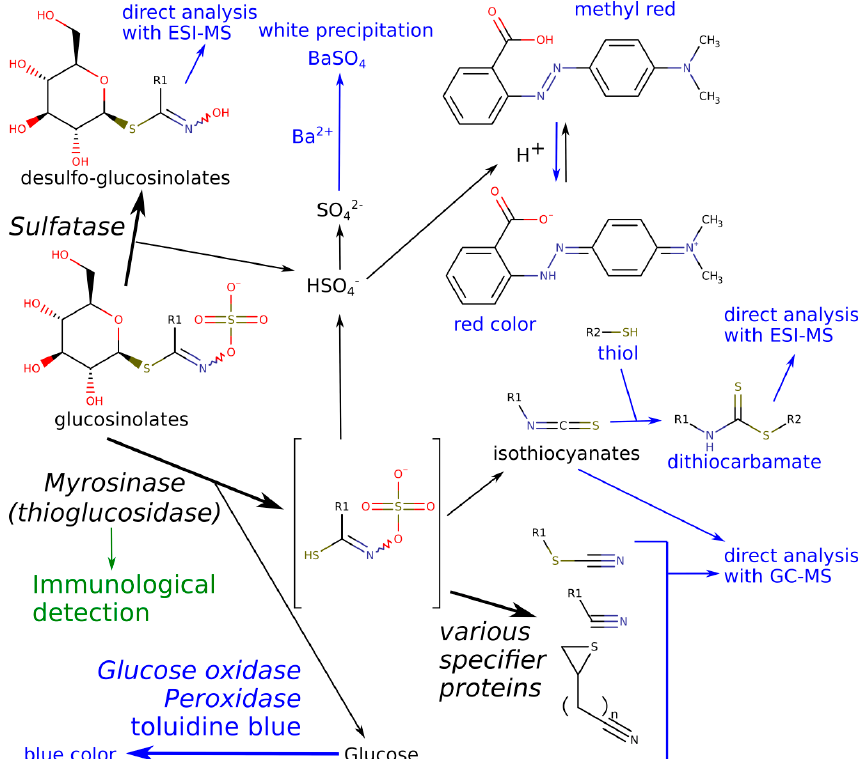
Figure 1. The main breakdown scheme of glucosinolates with possible detection methods of the products. Enzymatic reactions are shown with bold arrows, enzymes have italic font. The reactions that occur in vivo, are shown in black. Detection methods are either blue (those which require an operating myrosinase) or green (methods reliant only on similarity of sequences). The default rearrangement products of the thiohydroximates are isothiocyanates, alternative reaction products (from top to bottom) are nitriles, thiocyanates and epithionitriles. In our model, R1 = allyl- (sinigrin is converted to allyl isothiocyanate), R2 = 2-aminoethyl- (cysteamine).